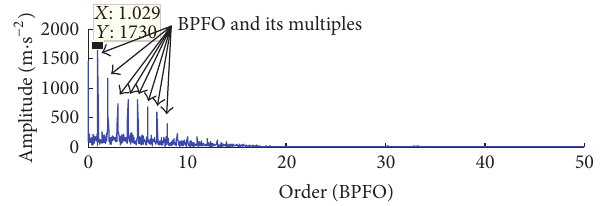
Figure 20: The order envelope demodulation spectrum of the outer race vibration